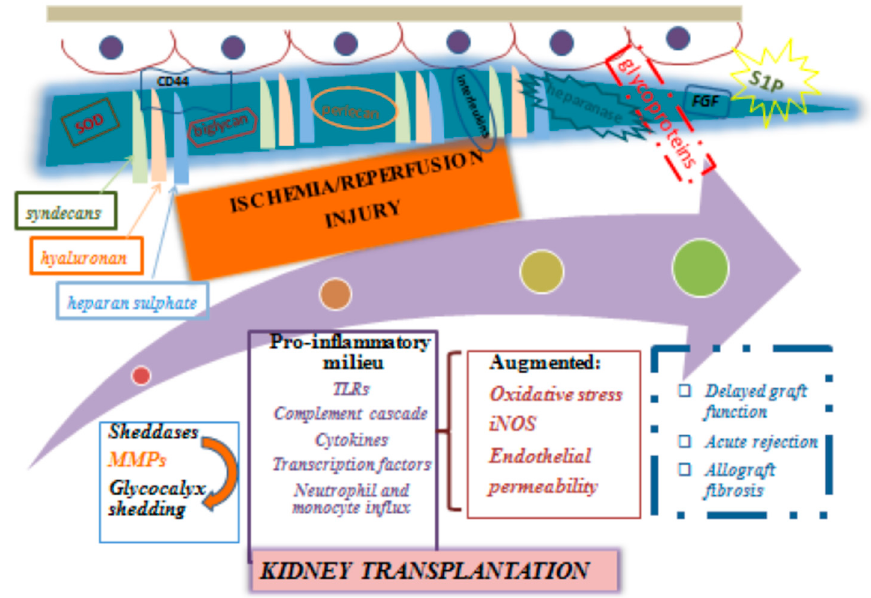
Figure 1. Clinical implications of glycocalyx damage in the setting of ischemia and/or reperfusion injury following kidney transplantation. FGF, fibroblast growth factor; iNOS, inducible nitric oxide synthase; MMPs, matrix metalloproteinases; S1P, sphingosine 1-phosphate; SOD, superoxide dismutase, TLR, toll like receptors.